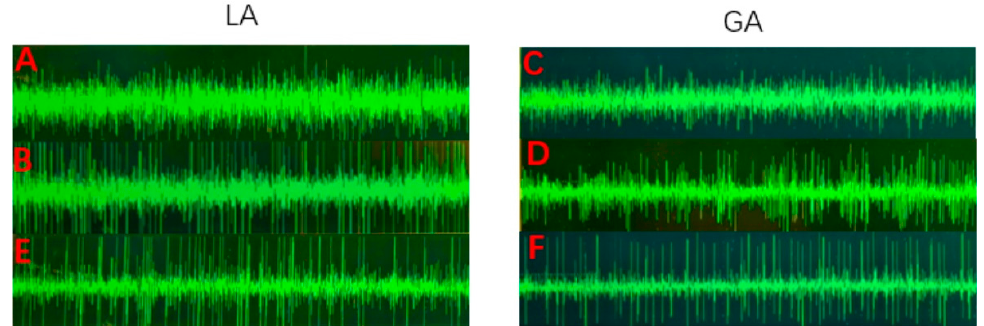
Figure 2. The MER of typical STN and SN under different anesthesia methods. ( A ). The medial of STN discharge under LA. ( B ). The lateral of STN discharge under LA. ( C ). The medial of STN discharge under GA. ( D ). The lateral of STN discharge under GA. ( E ). SN discharge under LA. ( F ). SN discharge under GA. MER, microelectrode recording; STN, subthalamic nucleus; SN, substantia nigra; GA, general anesthesia; and LA, local anesthesia.